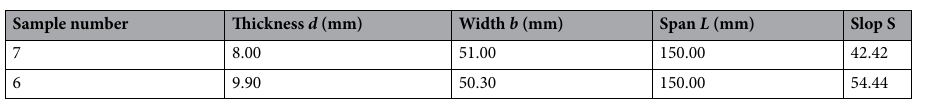
Table 2. The composite specimen’s dimensions used for the three-point bending moment test.